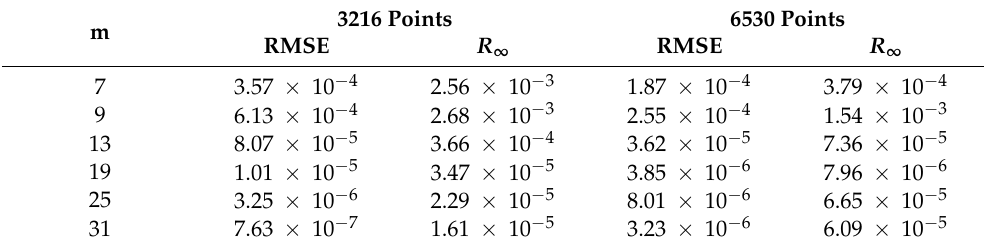
Table 6. Example No. 2—comparison of RMSE and R ∞ for different numbers of supporting points.